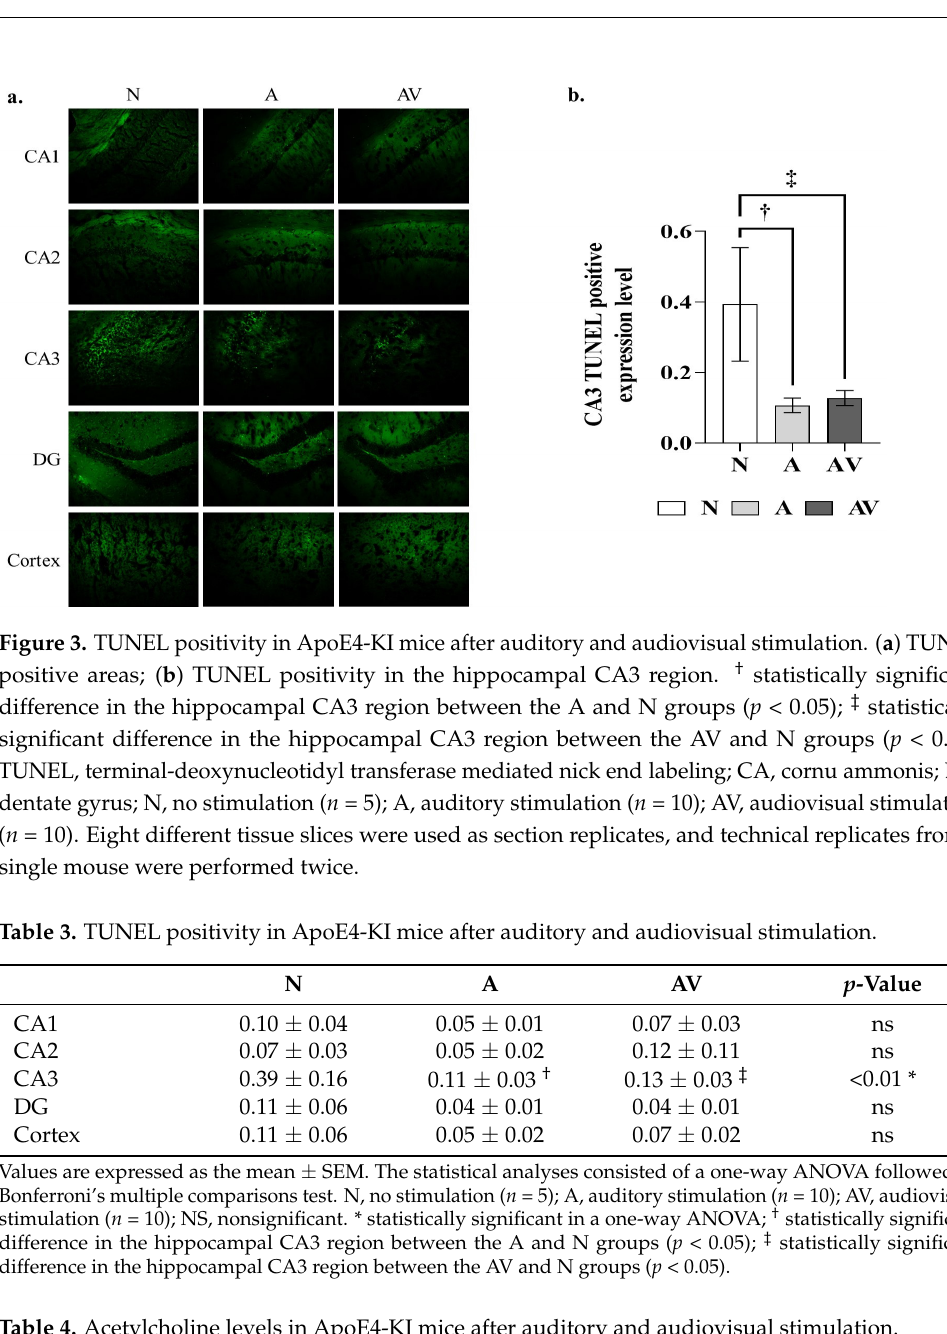
Table 4. Acetylcholine levels in ApoE4-KI mice after auditory and audiovisual